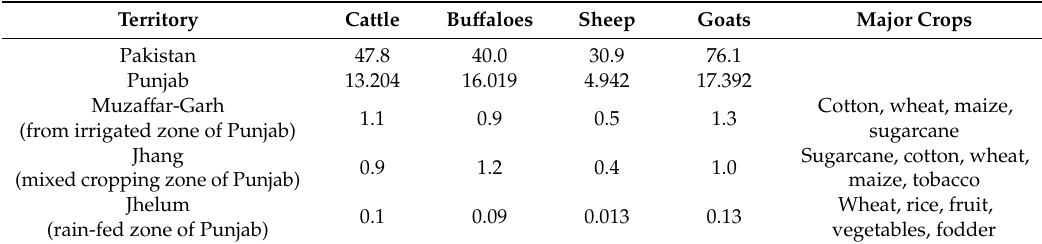
Table 1. Number of Dairy Animals in the Study Area (millions). Territory Cattle Bu ff aloes Sheep